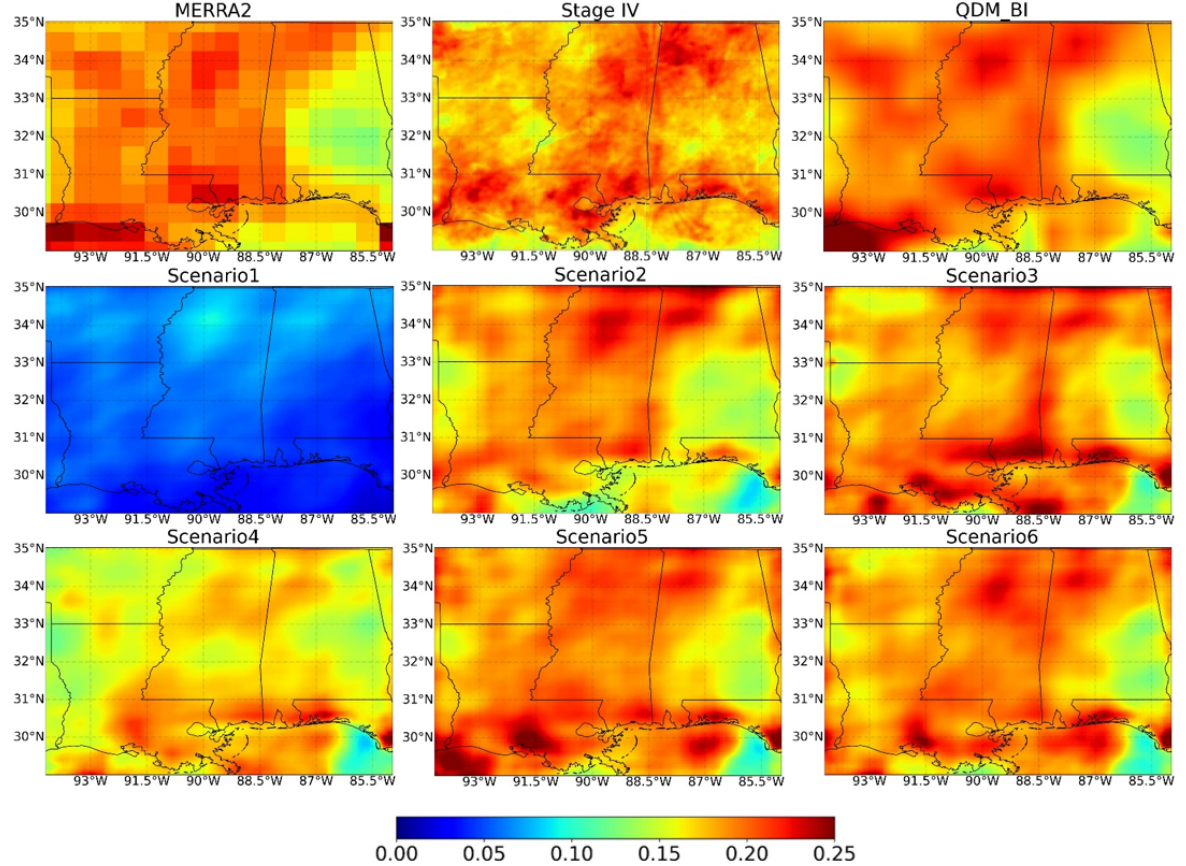
Figure 3. Hourly precipitation climatology (in a unit of mmh − 1 ) during the testing period (2019–2021), which includes MERRA2, Stage IV, QDM_BI, and the six DL experimental runs